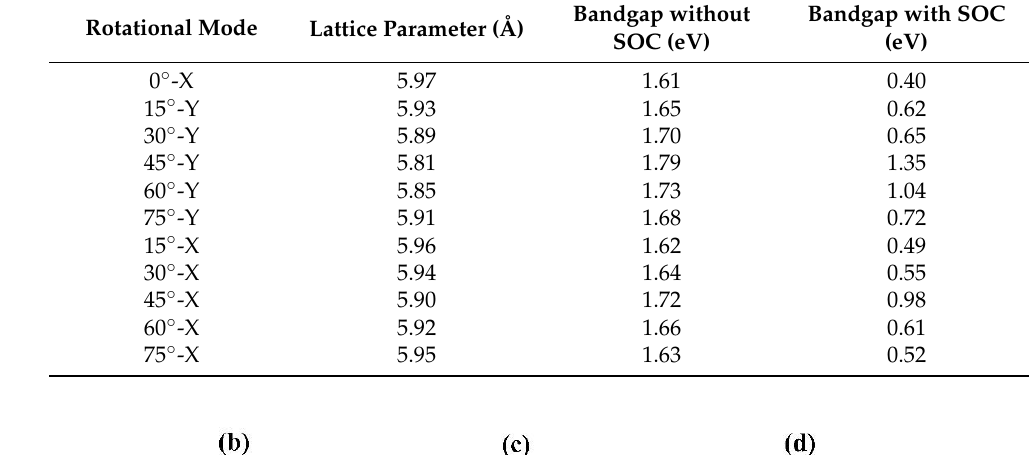
Table 1. Lattice parameters and bandgaps (with and without SOC) of FAPbBr 3 perovskite for all rotational modes.